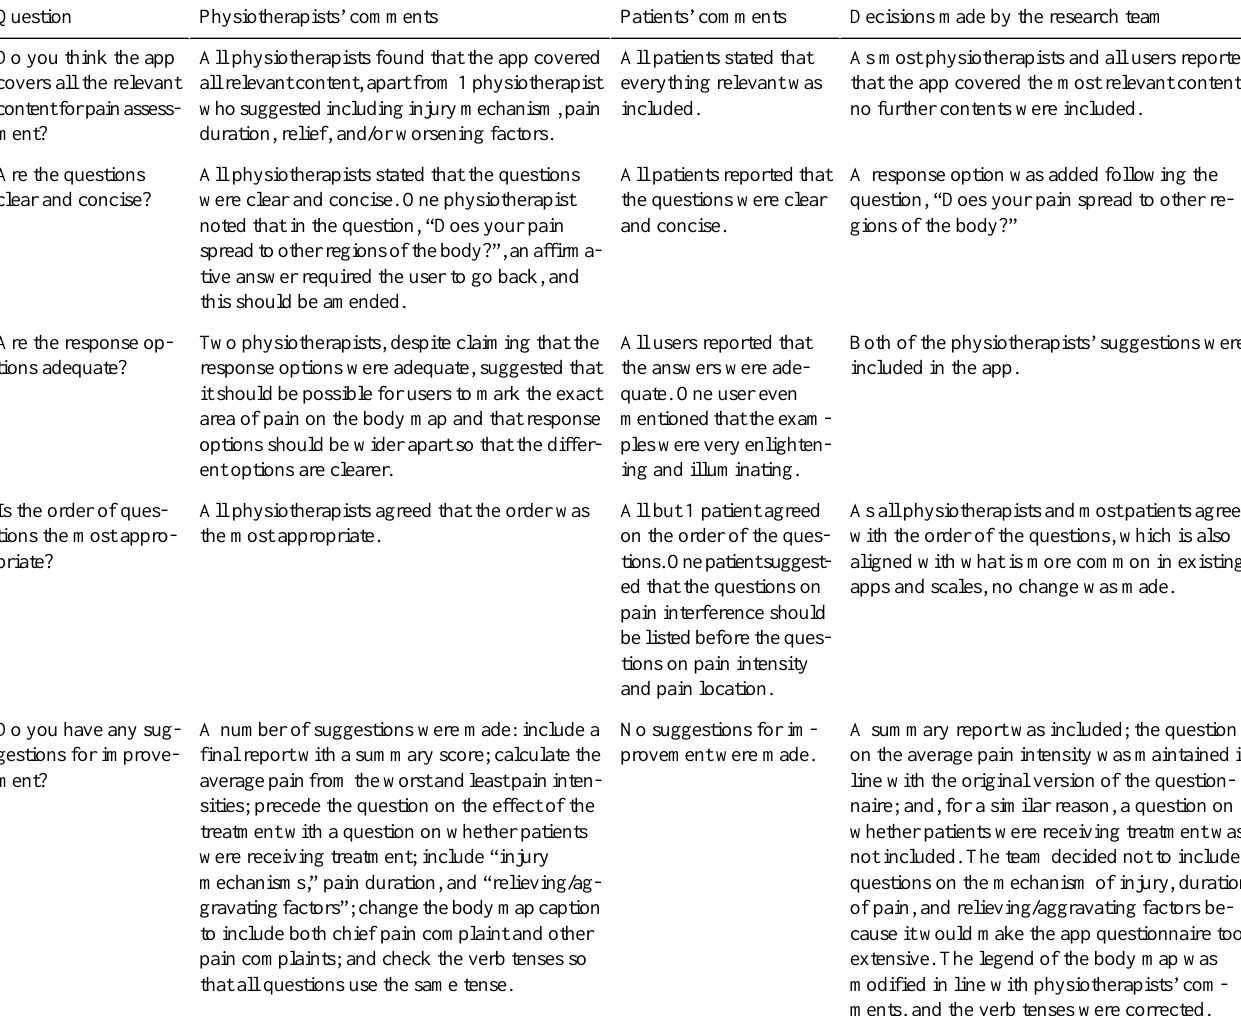
Table 3. Summary of physiotherapists’and patients’comments on the mock-ups of the AvaliaDor